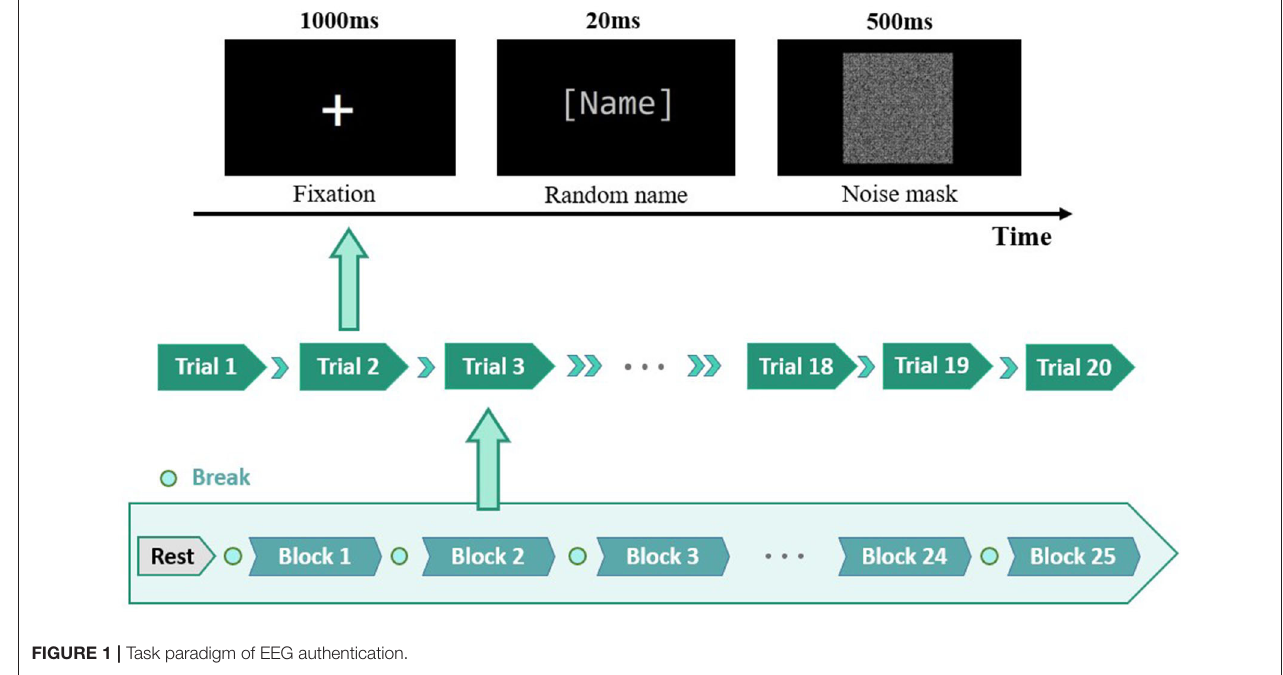
FIGURE 1 | Task paradigm of EEG authentication.